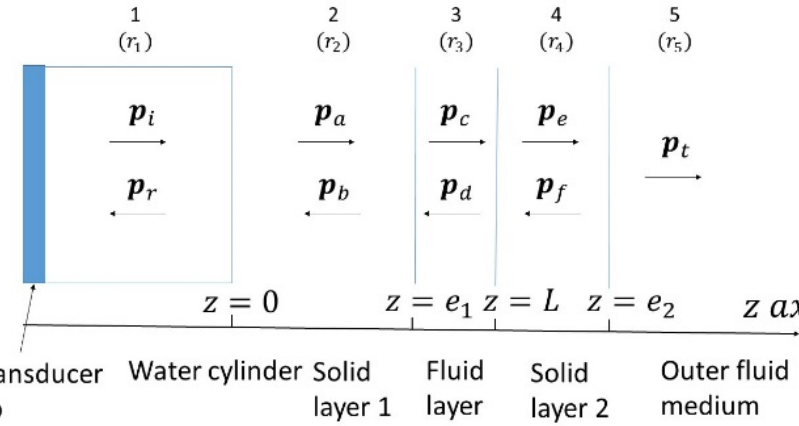
Figure A1. Schematic representation of an ultrasonic wave transmission and reflection in five layers adapted from the three layer problem described in [34]. If GUVs or cells are used, they are located in medium 3: The GUVs in suspension, and the cells either attached at z = e1, or z = L, or in suspension.